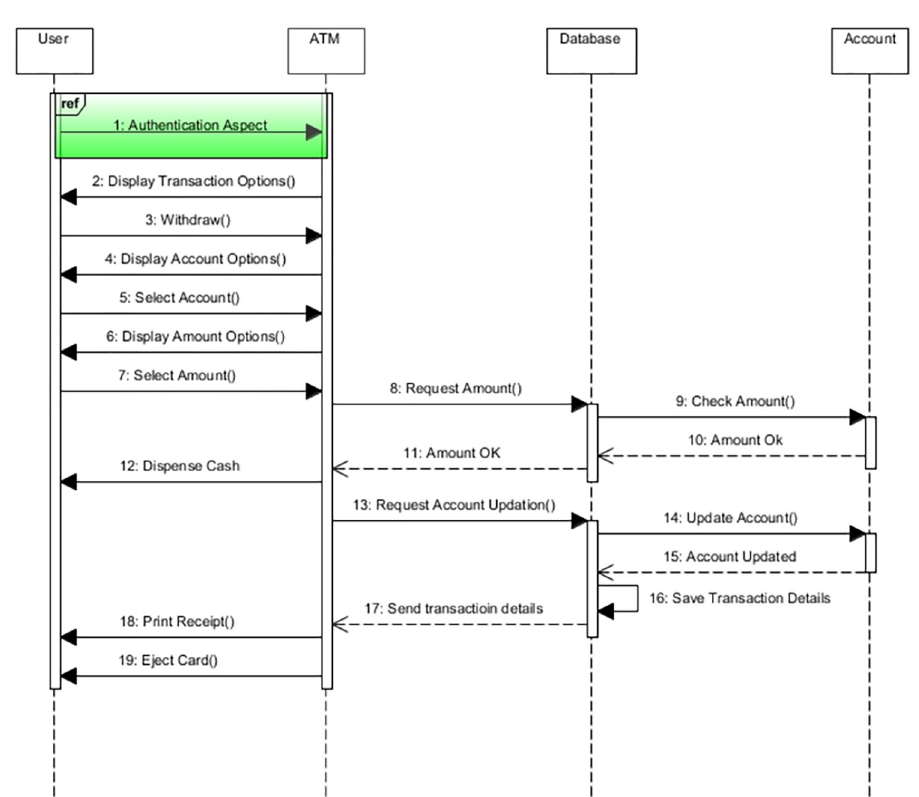
Fig 12. Aspect-oriented mal sequence woven model (woven model).